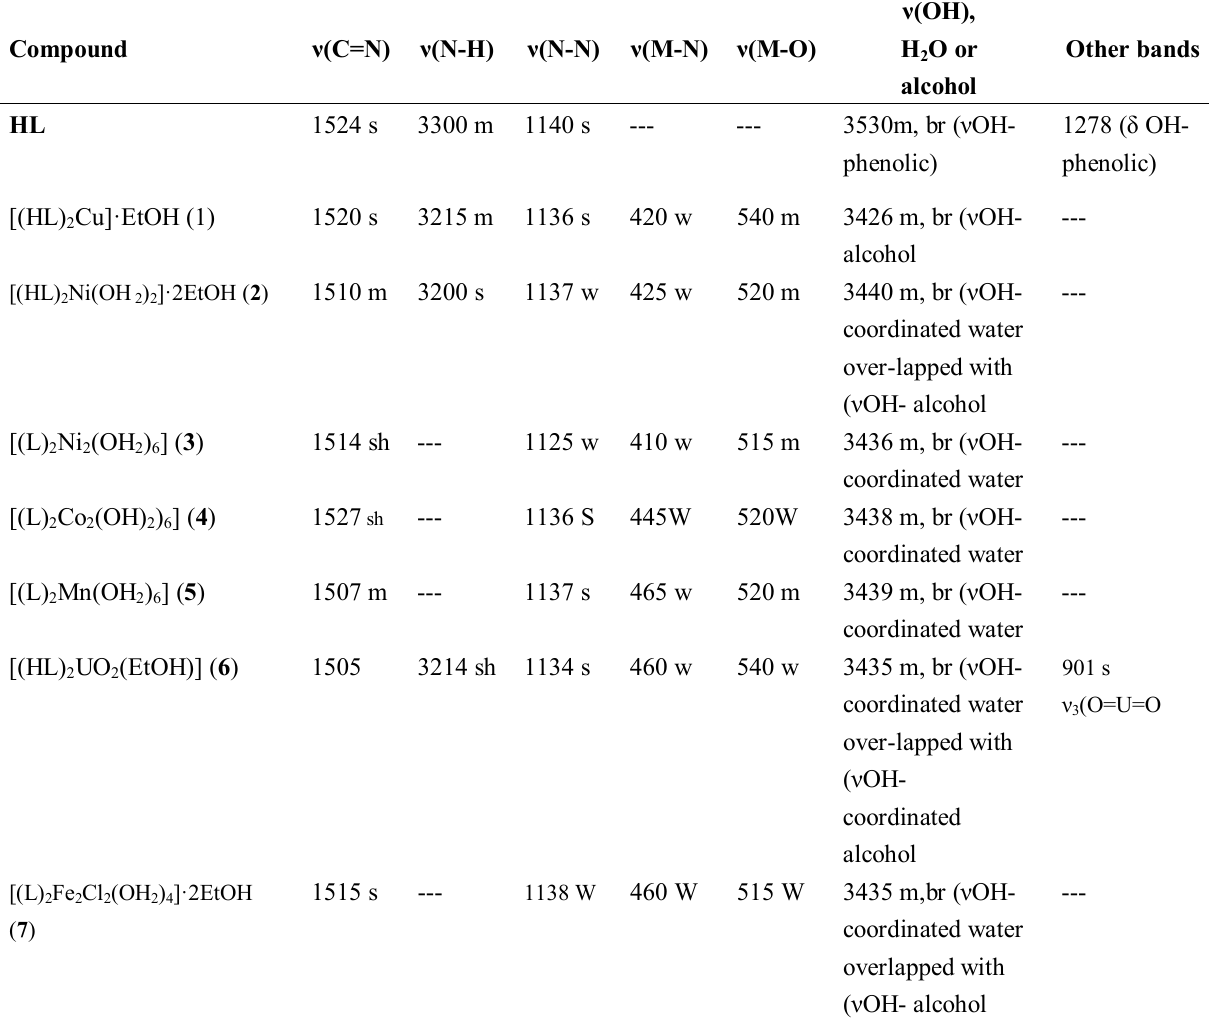
Table 3. Characteristic IR bands (cm − 1 ) of the HL and its corresponding metal